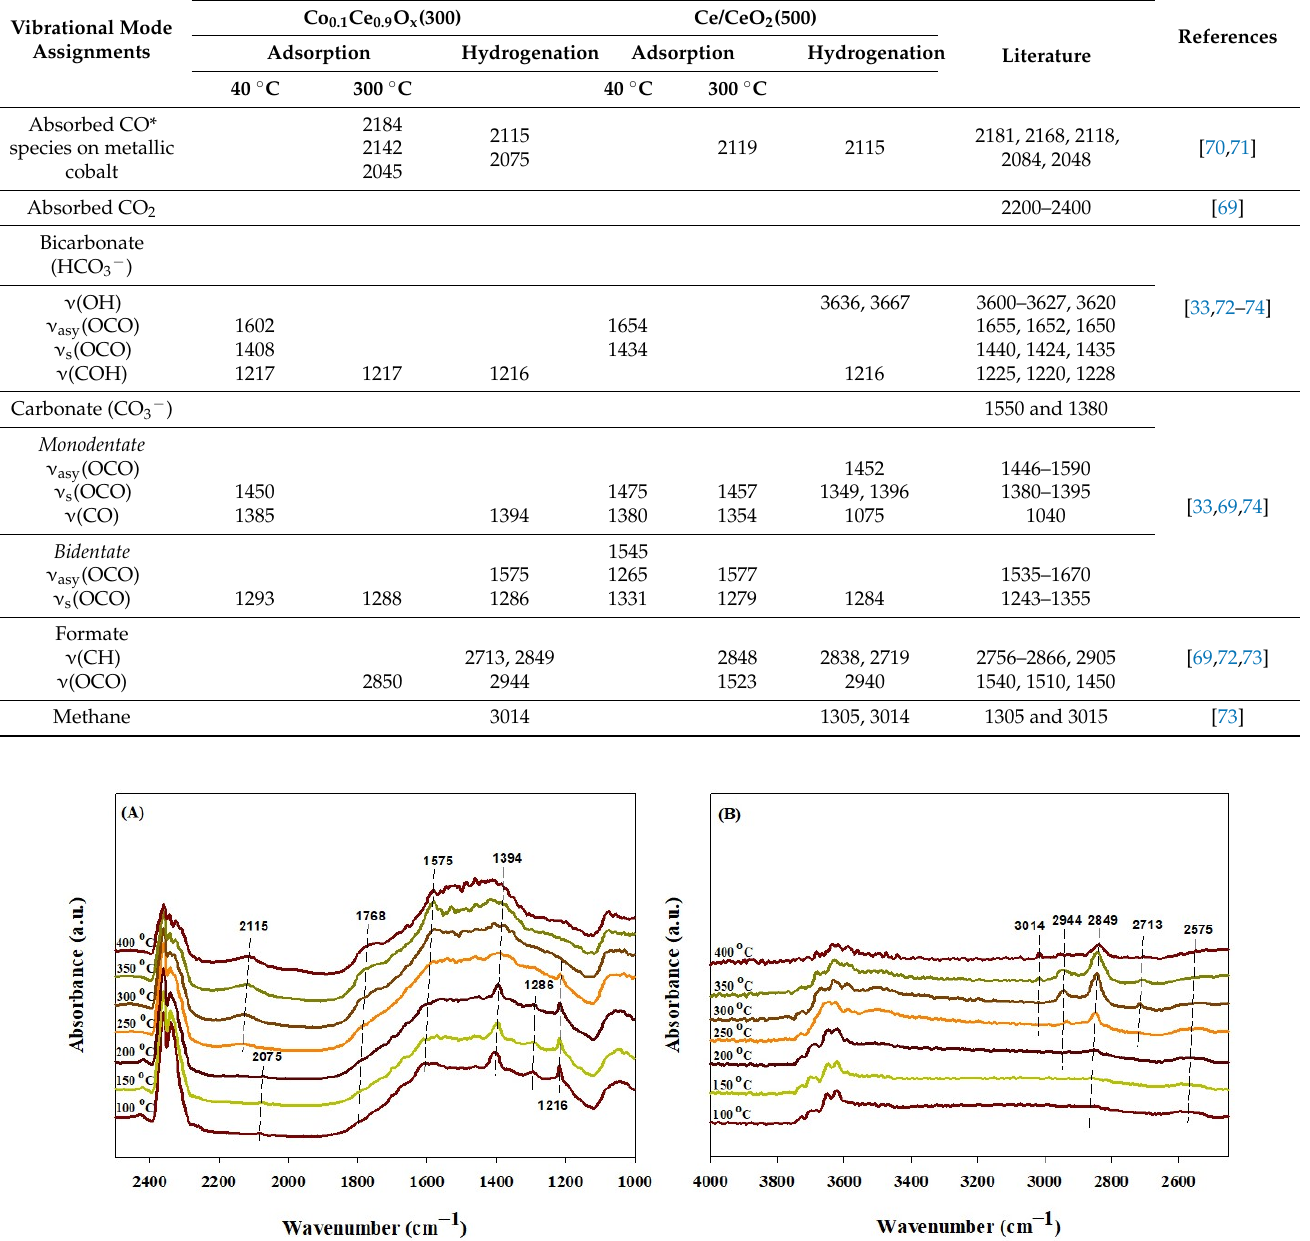
Figure 5. In situ DRIFTS spectra after adsorption of CO 2 on Co 0.1 Ce 0.9 O x (300) ( A ) and Co/CeO 2 (500)